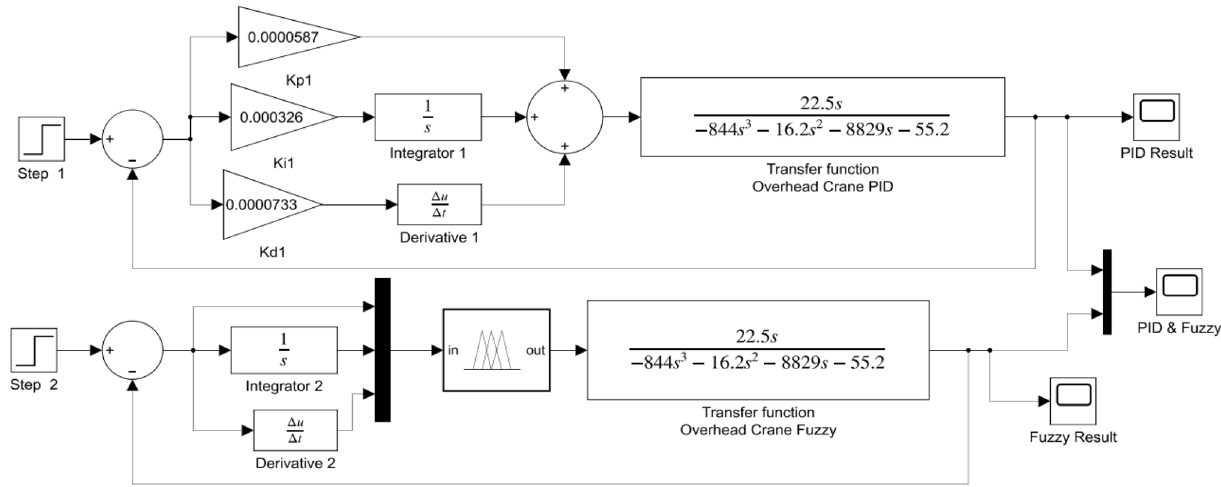
Fig. 15 Simulink Model for both conventional PID controller and FLC for swinging motion of the crane